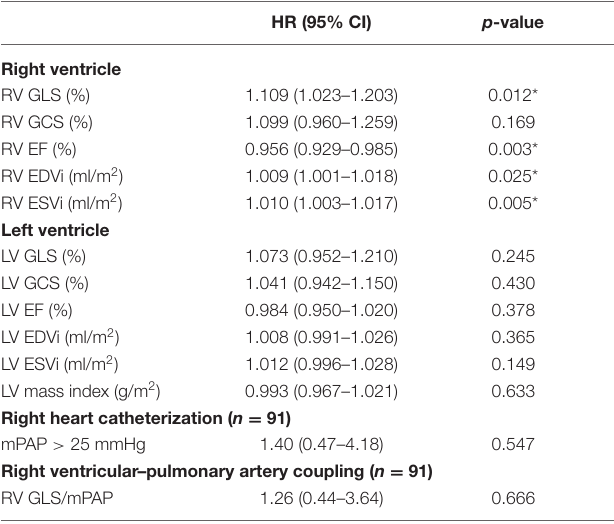
TABLE 2 | Univariate Cox regression of right and left ventricular parameters for 1-year all-cause mortality. HR (95% CI) p -value